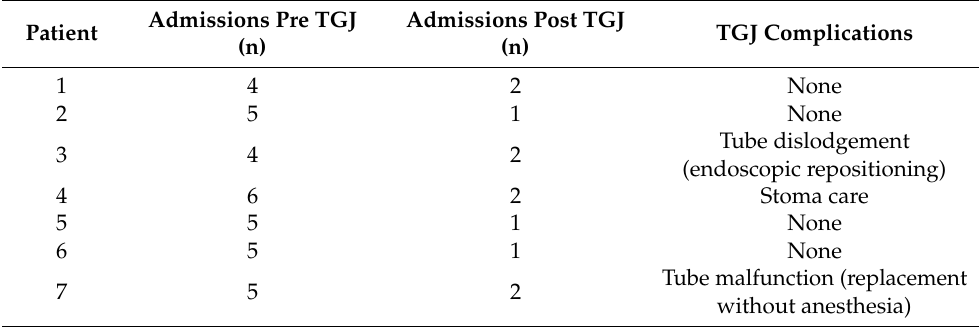
Table 4. Number (n) of admissions pre- and post-transgastric jejunostomy (TGJ) placement and complications related to